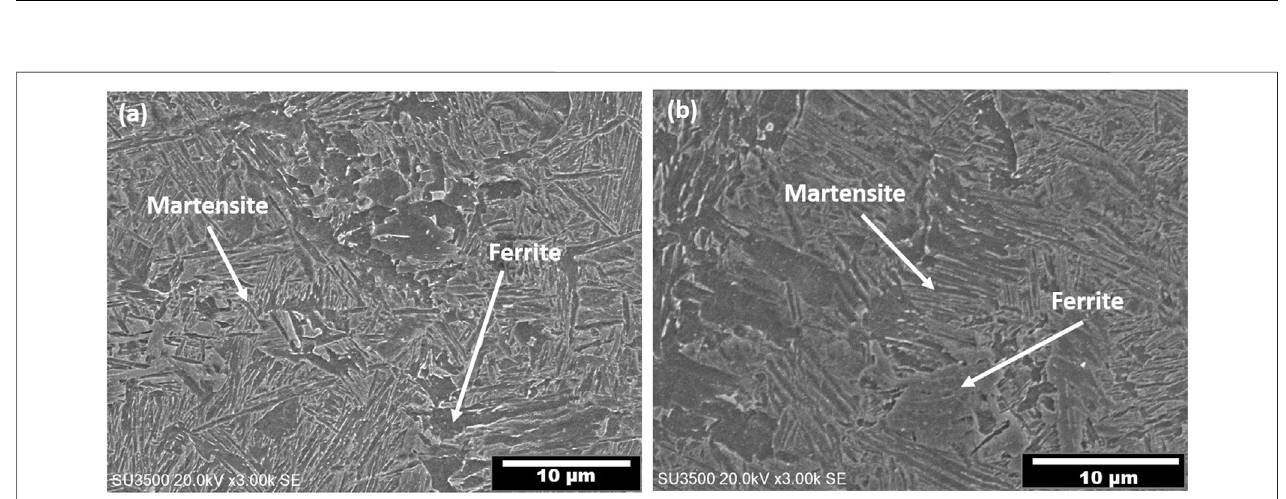
FIGURE 7 | The scanning electron micrographs of images of samples after the 5th deformation using interpass times of 20 s.